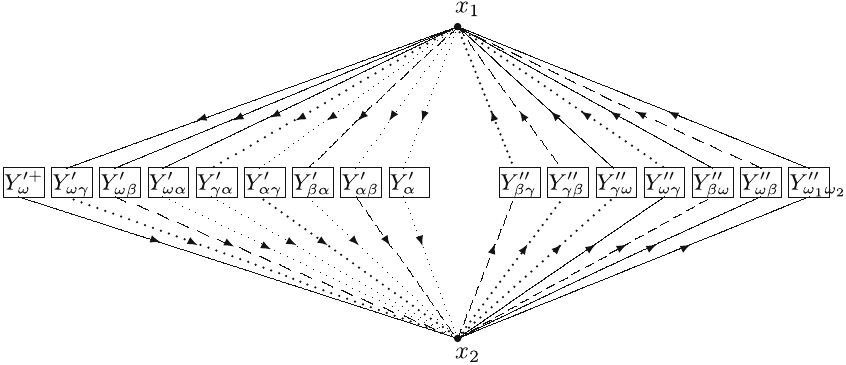
Figure 2: An arc - coloured bipartite tournament for Case 1 of the proof of Lemma